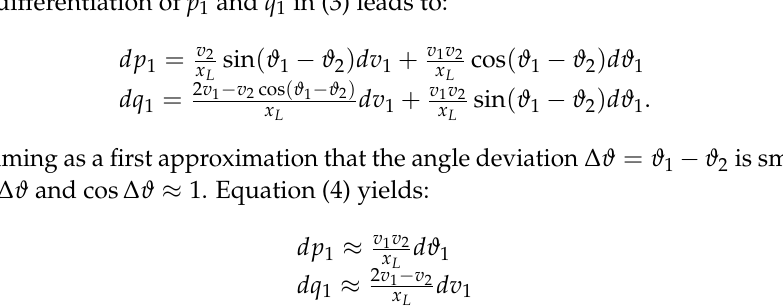
v ϑ∠ , such a system could represent the bulk 2 2